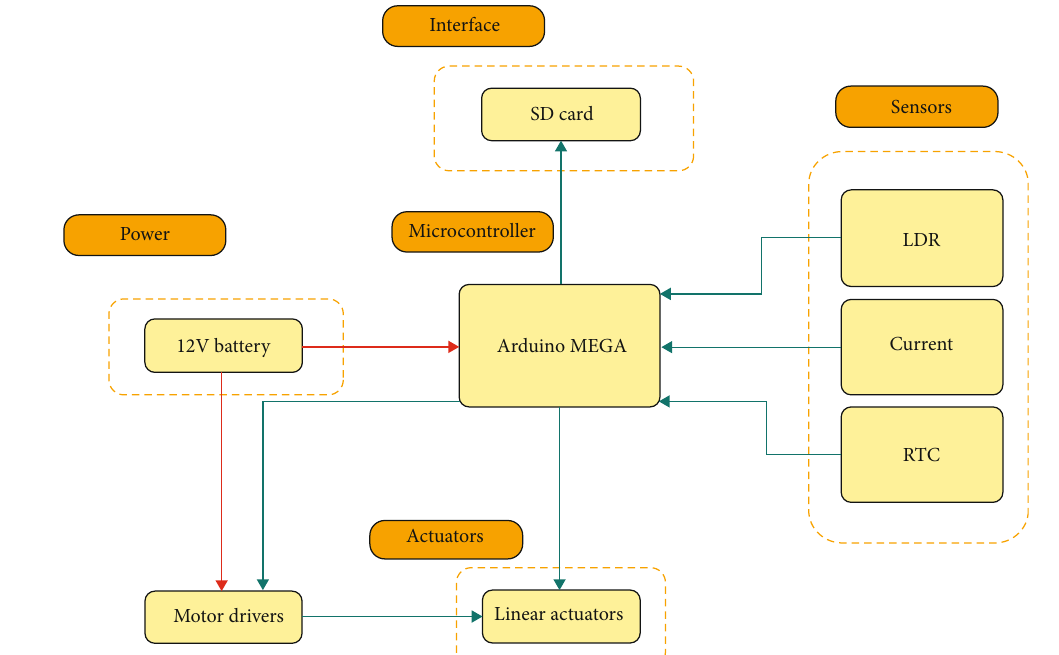
Figure 3: Electrical block diagram for SAST and DAST.